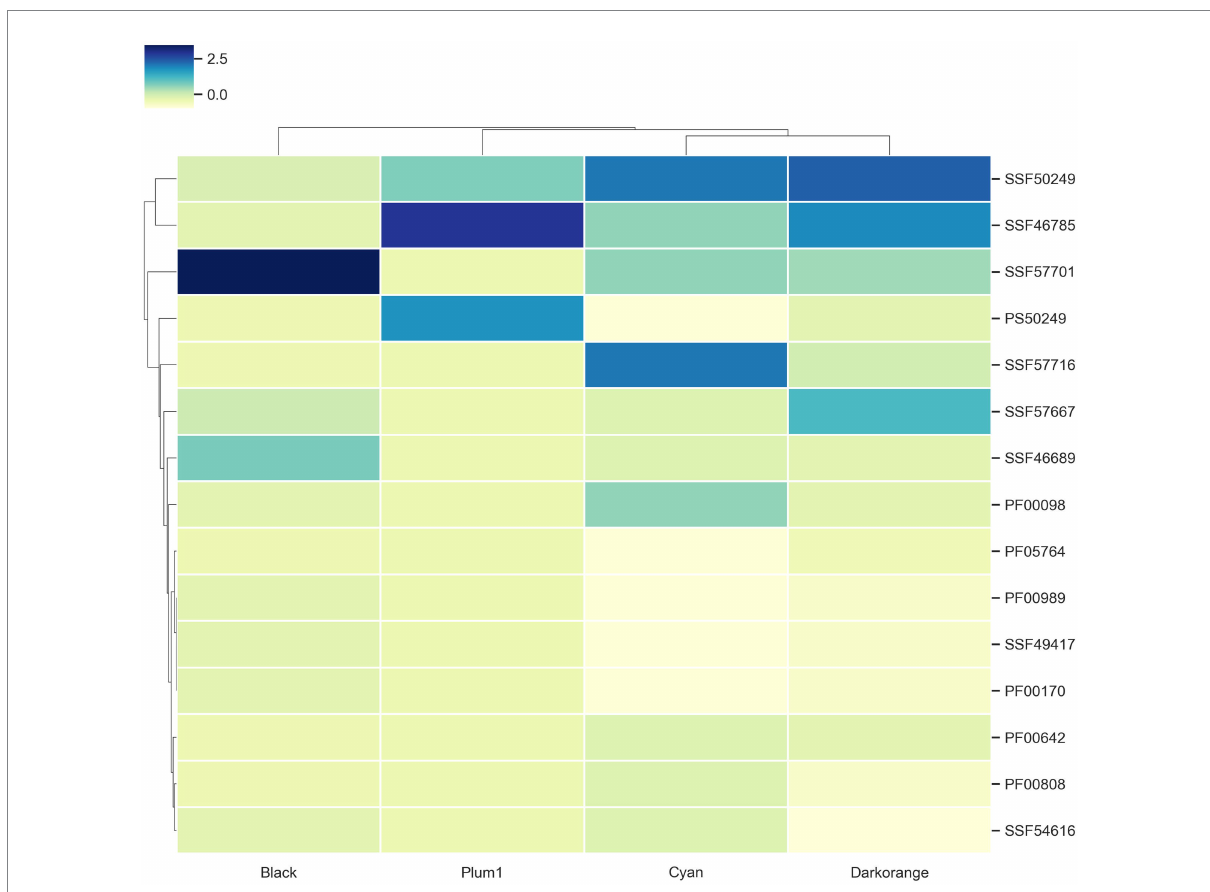
FIGURE 4 TF families identified as frequent in the enriched modules. Z-score hierarchical clustering based on Euclidean distance measure and Ward’s method for linkage analysis. Each row represents the superfamily ID.